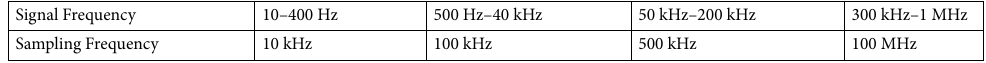
Table 1. The signal frequency and the corresponding ADC sampling